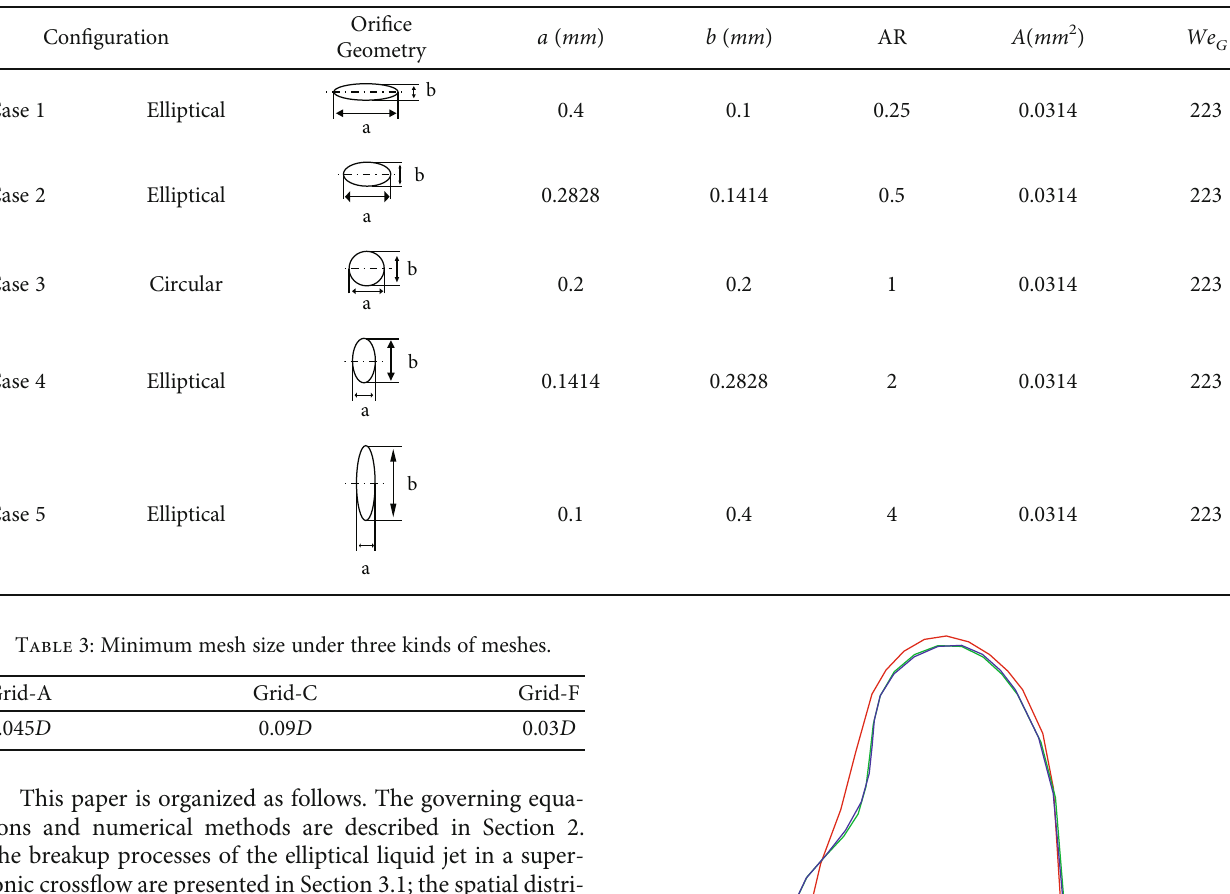
Table 2: Geometries of injection nozzles (cross fl ow is from left to right).